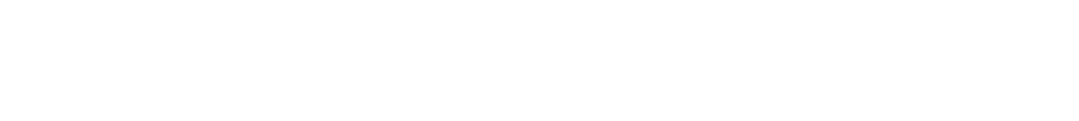
FIGURE 5 | (A) In this section, T. evansi (arrow) and a macrophage (MAC) are seen. (B) Section showing L. mexicana organisms inside of an eosinophil (arrowheads) and a macrophage